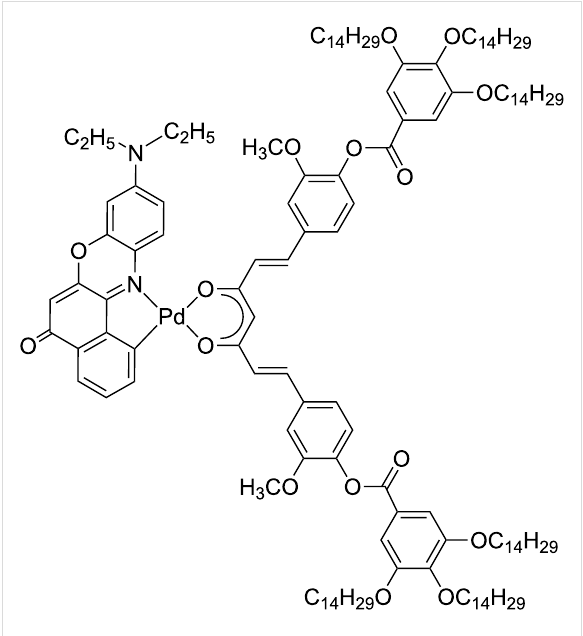
Figure 1: Molecular structure of NIRPAC: a Pd(II) complex based on Nile red and a curcumin